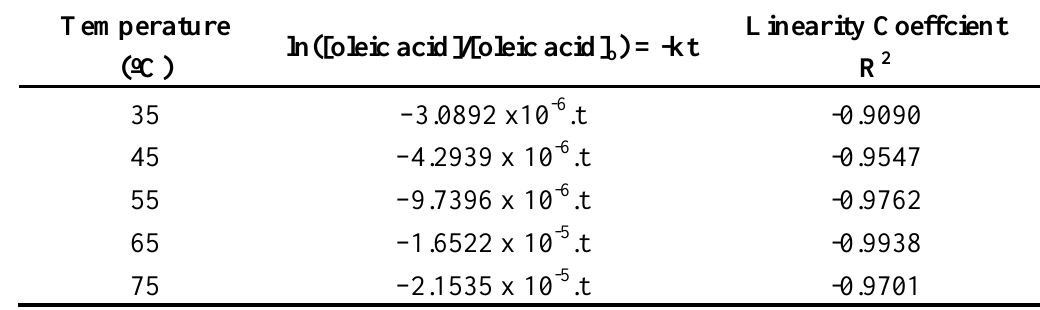
Table 3 . Linear equations for the decrease in oleic acid concentration as a function of time and the respective values of R 2 and K.